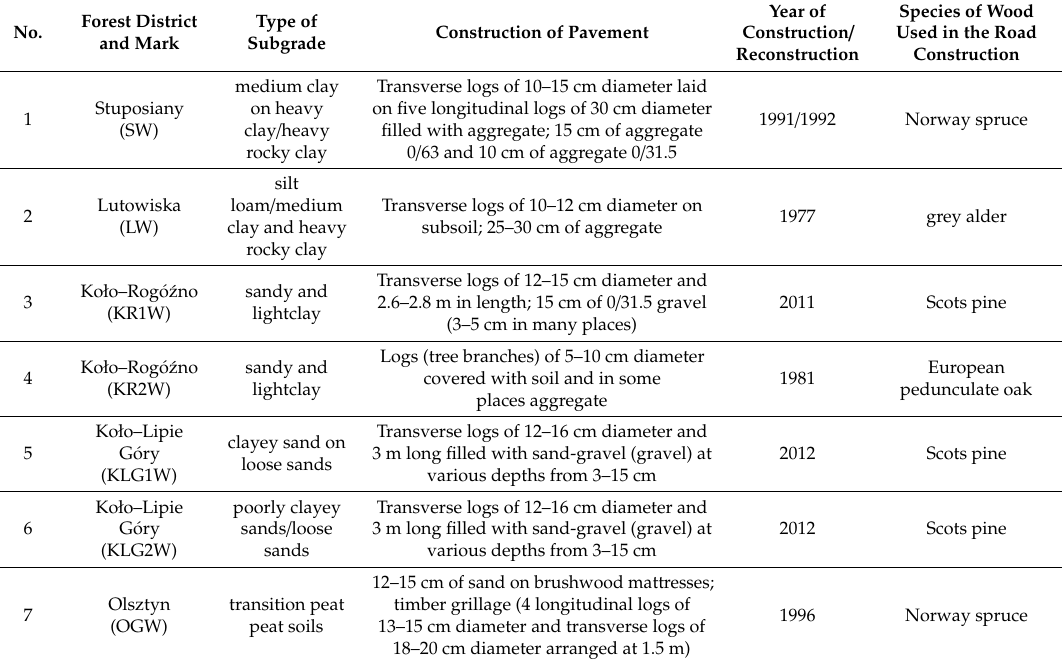
Table 1. Characteristics of forest road construction on a subgrade reinforced with timber